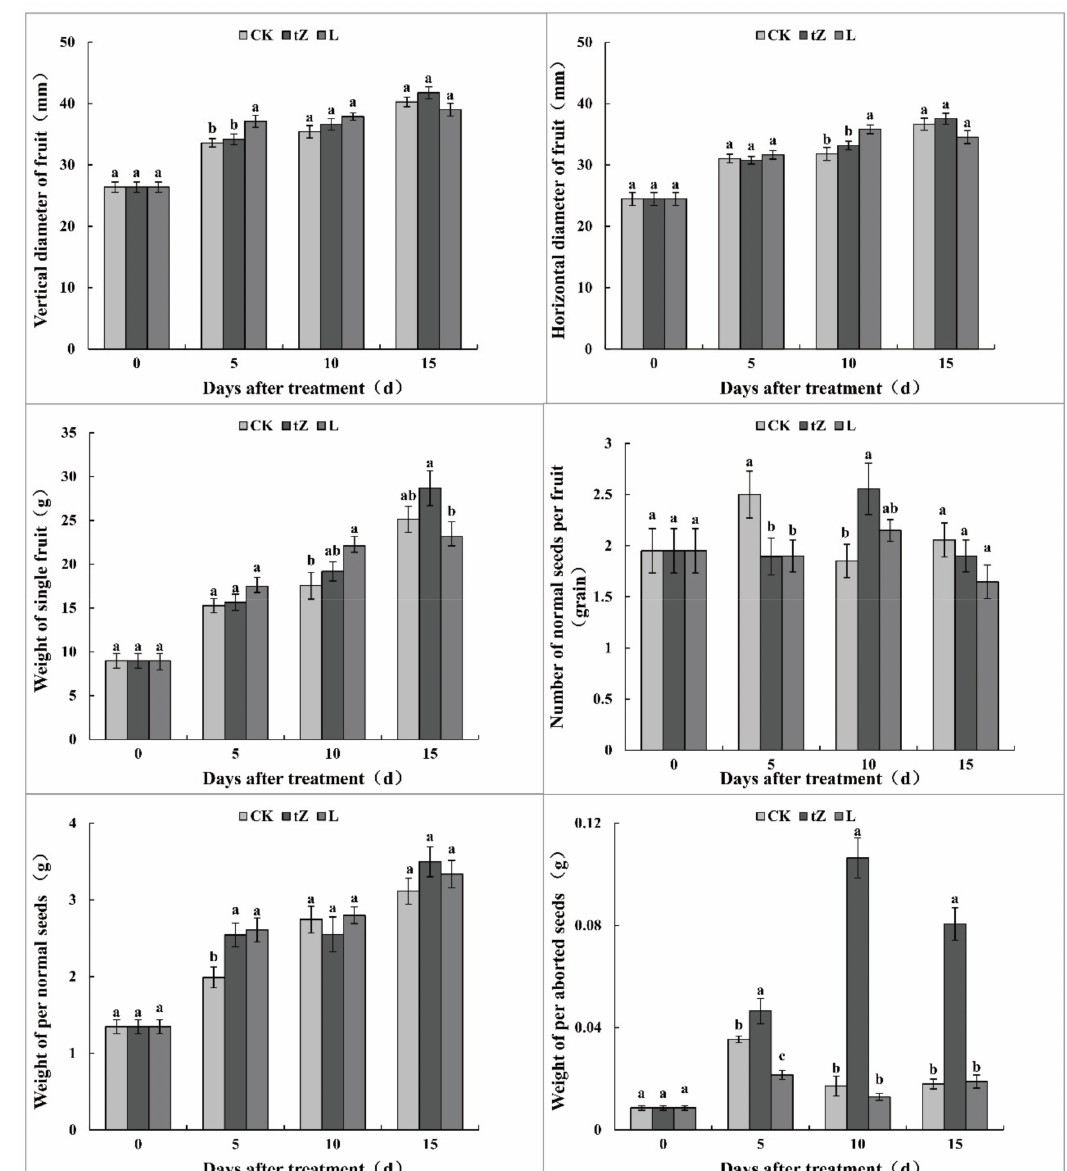
Figure 1. Morphological indexes of loquat fruit treated with CK (clean water), tZ(trans-zeatin) and L(lovastatin). Different lower-case letters among different treatment groups indicate significant differences based on one-way analysis of variance in SPSS 21.0 followed by the Duncan’s test ( p <